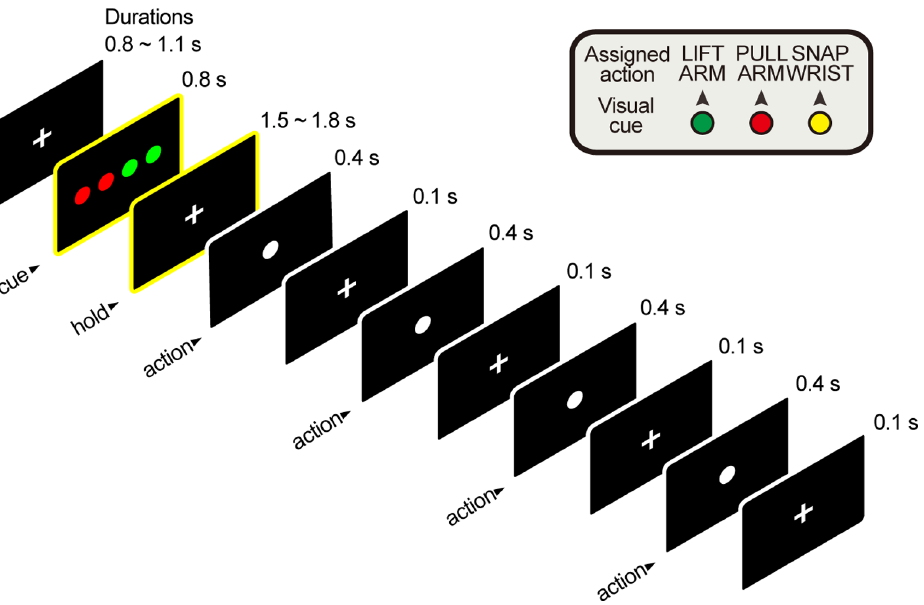
Figure 1. Schematic drawing of a ’Paired’ trial. The frames highlighted with yellow borders are the phase of interest. Data obtained during this period were analyzed.